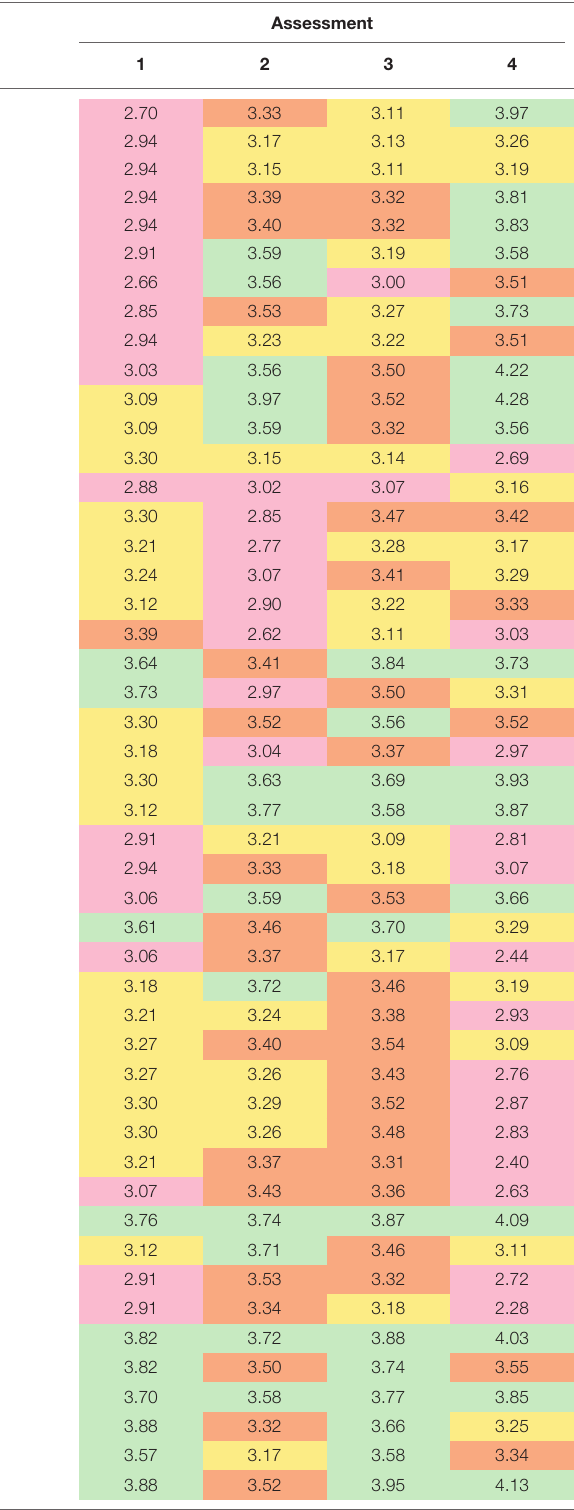
TABLE 6 | Comparison of resilience quartiles between the four assessments at each site, where: Q1 (red, low resilience) is < 3.09, Q2 (orange) is 3.09–3.31, Q3 (yellow) is 3.31–3.55, and Q4 (green, high resilience) is > 3.55.